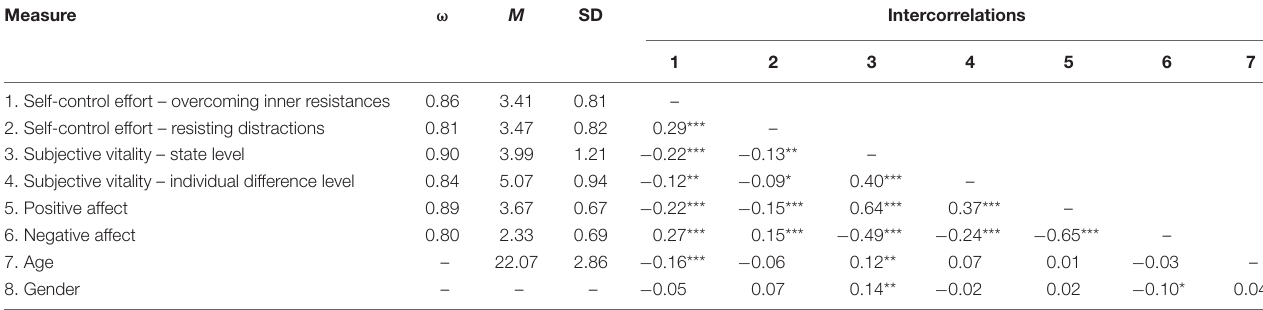
TABLE 1 | Descriptive statistics and intercorrelations of the applied measures. Measure ω M SD Intercorrelations